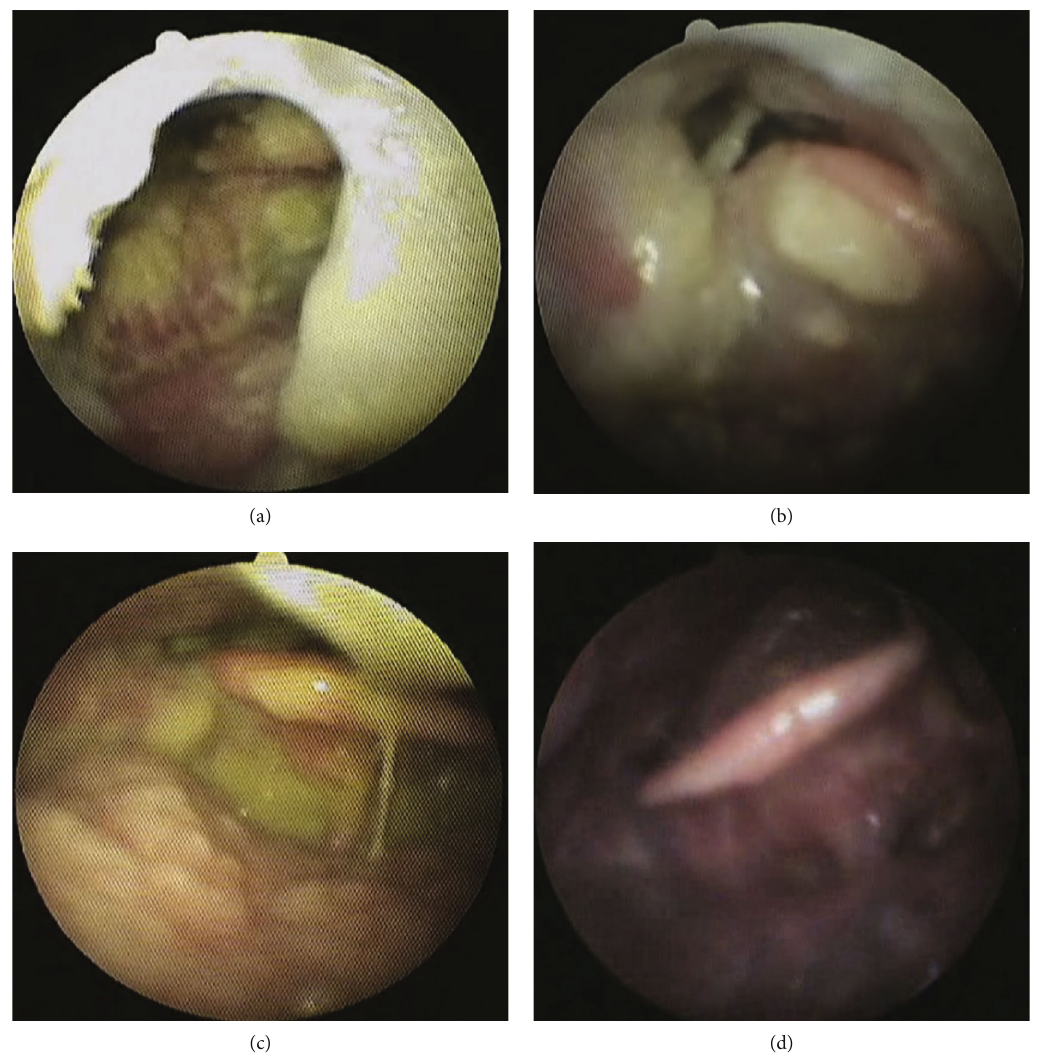
Figure 2: The membranous substances in the pharynx decreased gradually. Fiberoptic endoscopic pictures in the pharynx. (a) First examination, (b)14 days, (c) 37 days, and (d) 61 days after the fi rst